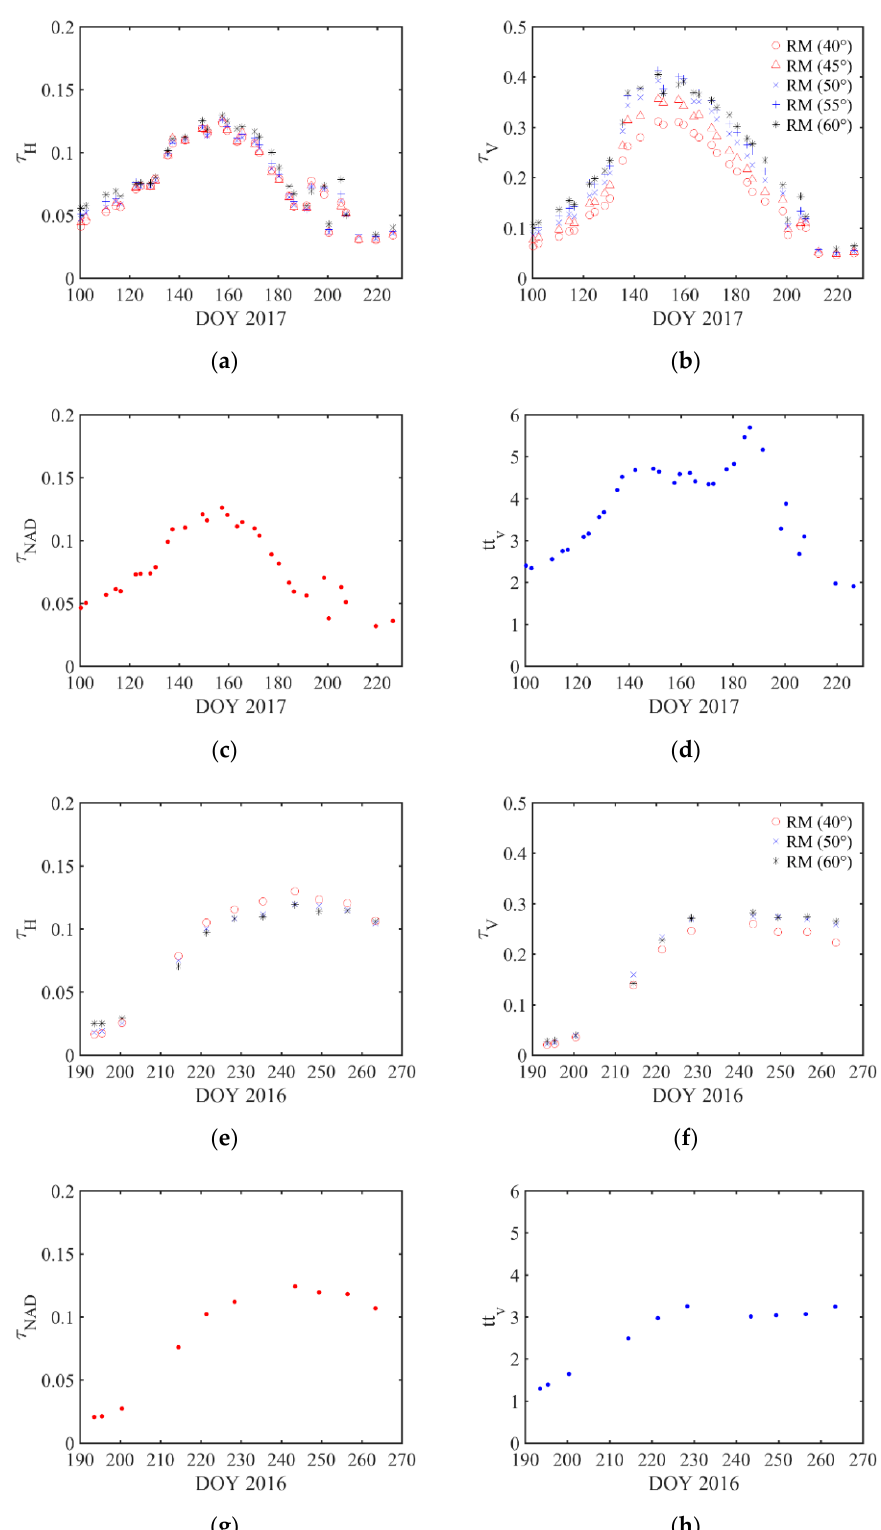
Figure 7. Retrieved vegetation optical depth ( τ p ) using the single-angle retrieval approach ( a , b and e , f ), and retrieved τ NAD and tt V parameters using the multi-angle retrieval approach ( c , d and g , h ) over the gridded plots within the winter wheat ( left ) and mustard ( right ) stands.